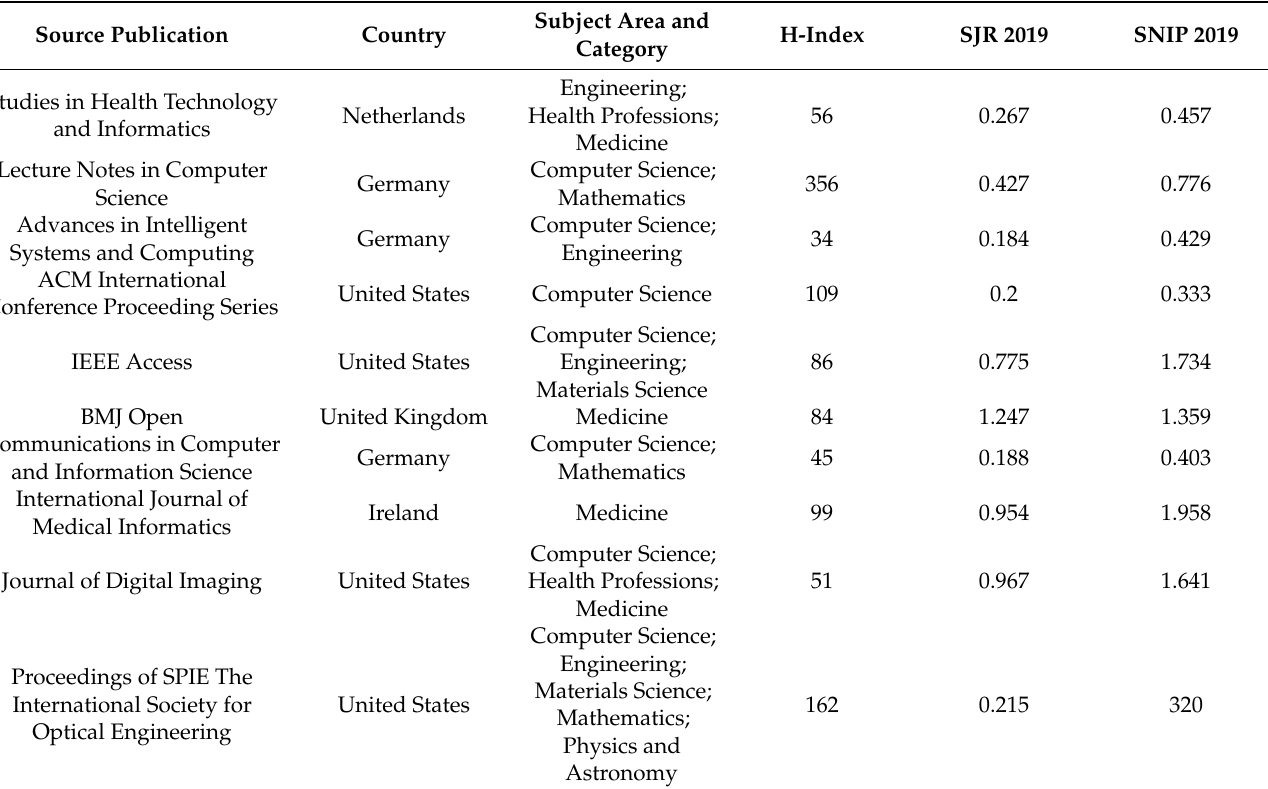
Table 3. Top ten source publications by number of